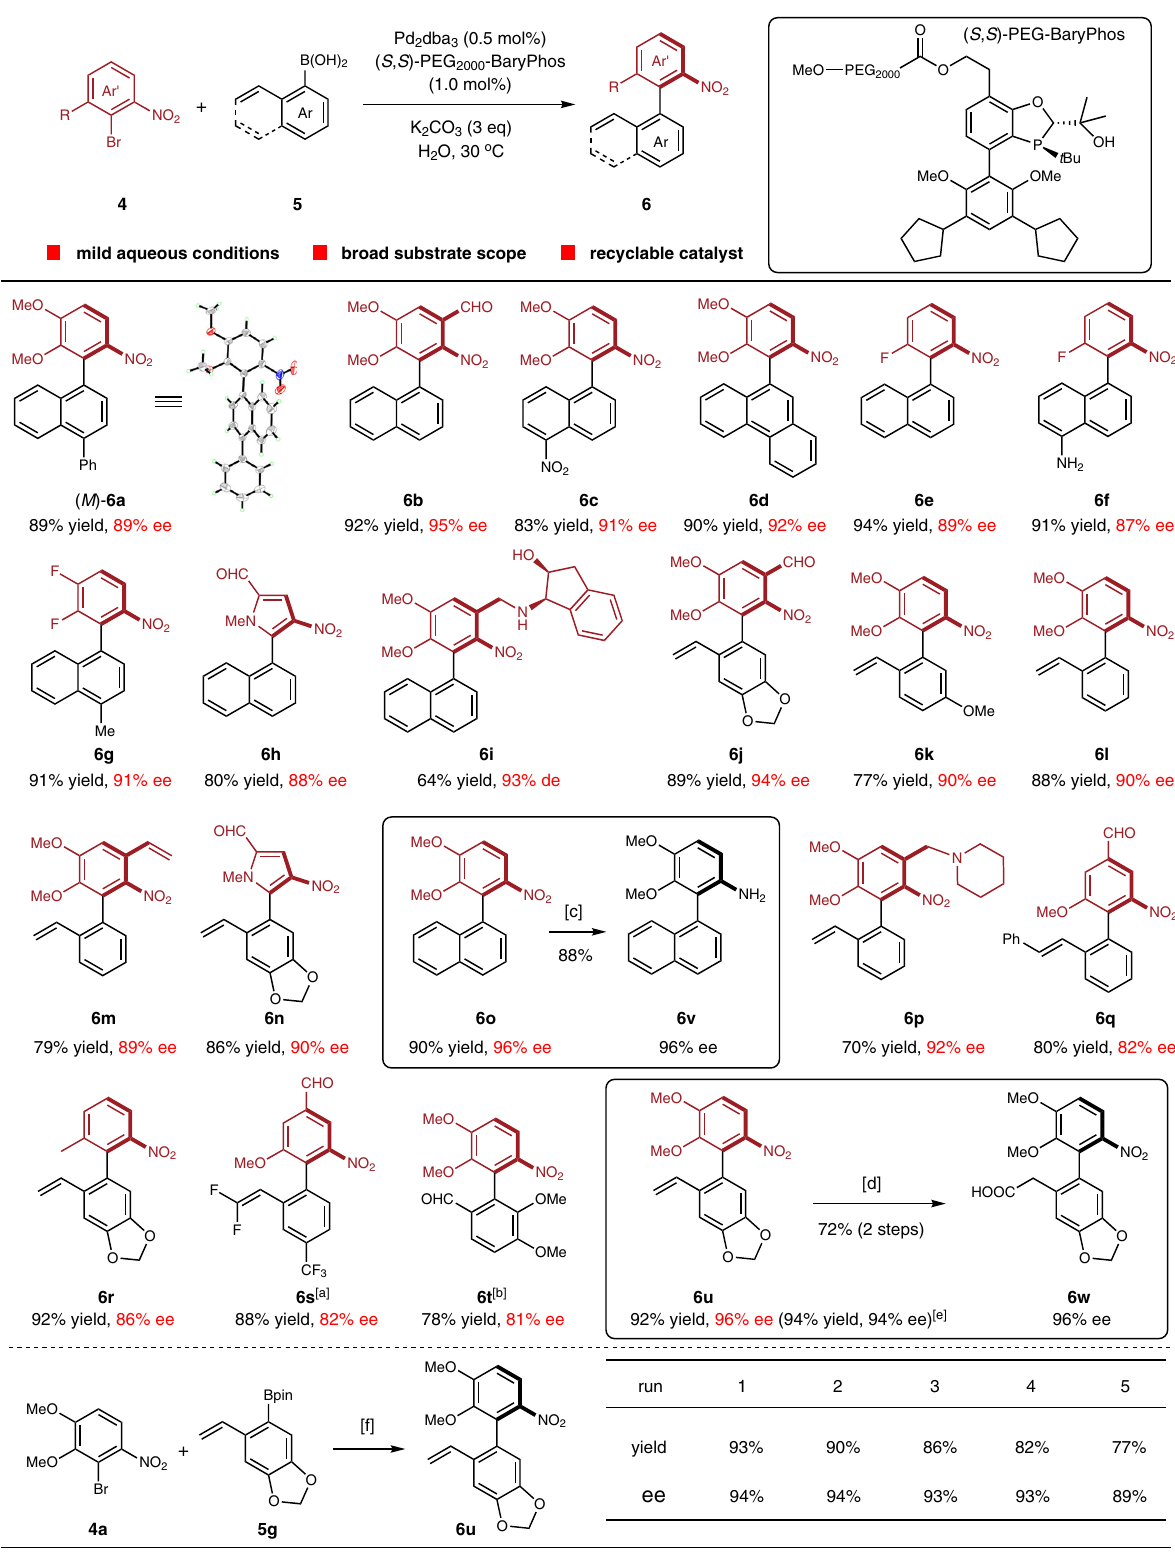
Fig. 4 | Synthesis of ortho nitro-substituted axially chiral biaryls. Details of the cross-coupling reactions and recycling experiments were provided in the Supple- mentary Methods 1.4 and 1.5, respectively; yields refer to isolated yields; the ee value was determined by HPLC; The absolute con fi guration of 6a was determined by X-ray crystallography and the structures of other products were drawn by analogy. a The corresponding arylboronic acid pinacol ester was employed. b The